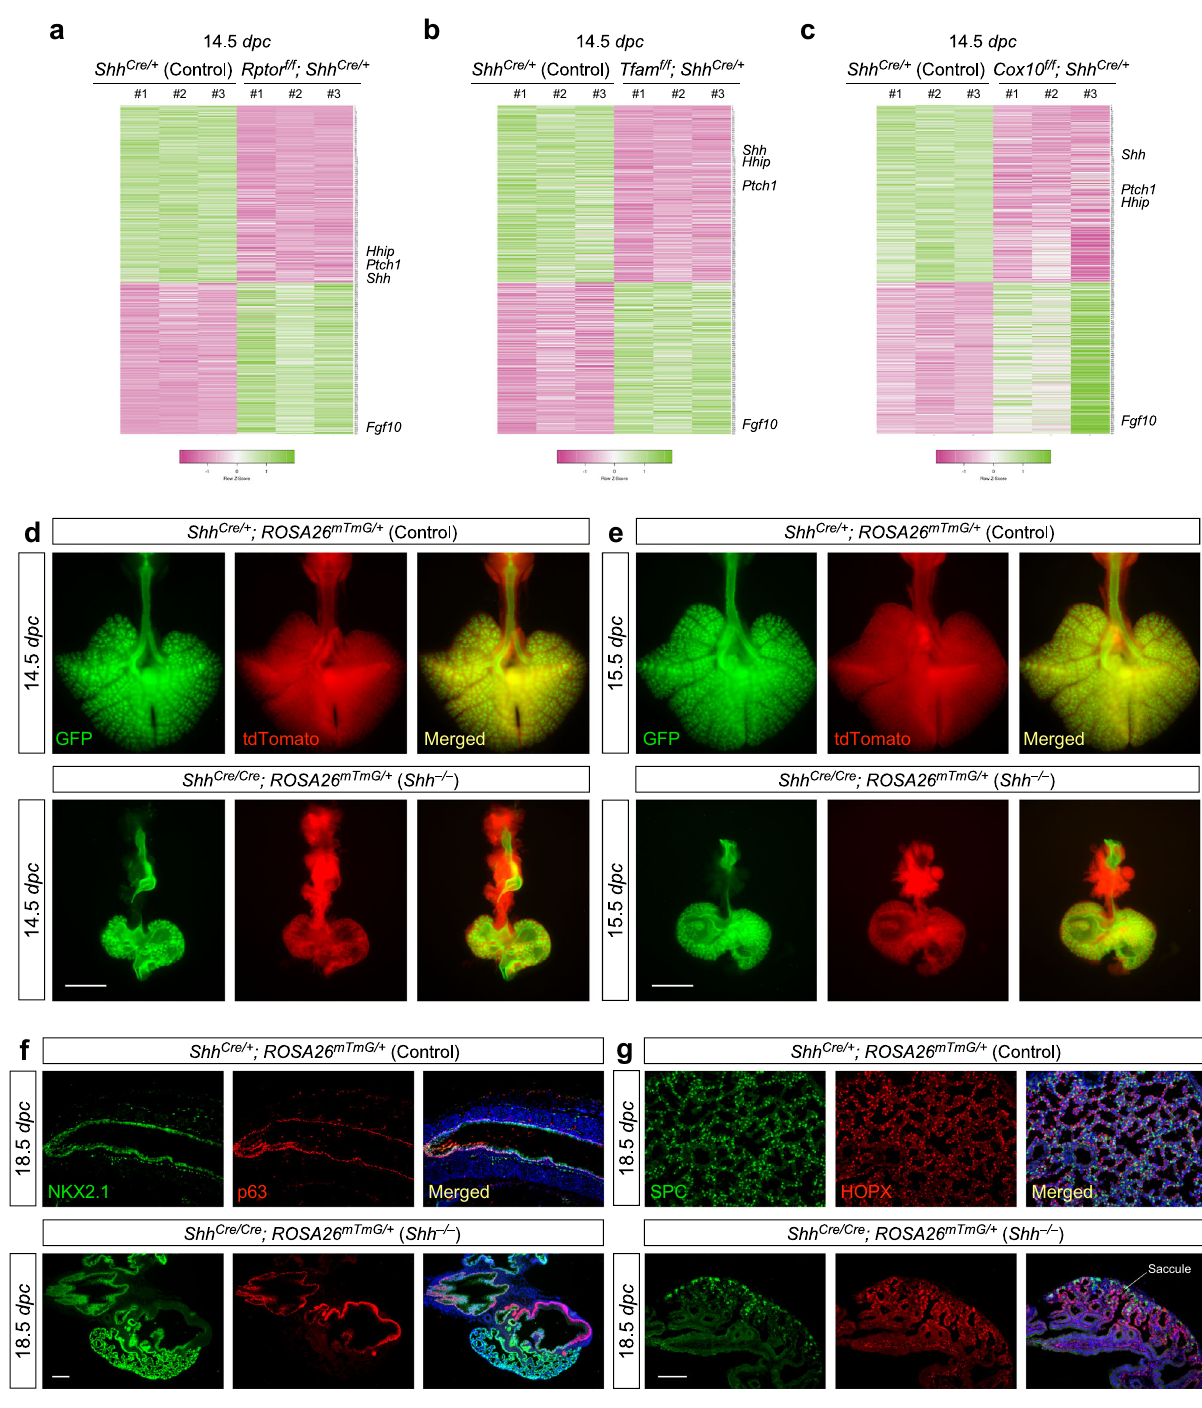
Fig. 9 | Defective Hh signaling perturbs the development of the conducting airwayswithoutaffectingsacculeformation.a , b , c Heatmapofgeneexpression from control ( Shh Cre/+ ), Rptor f/f ; Shh Cre/+ , Tfam f/f ; Shh Cre/+ and Cox10 f/f ; Shh Cre/+ lungs